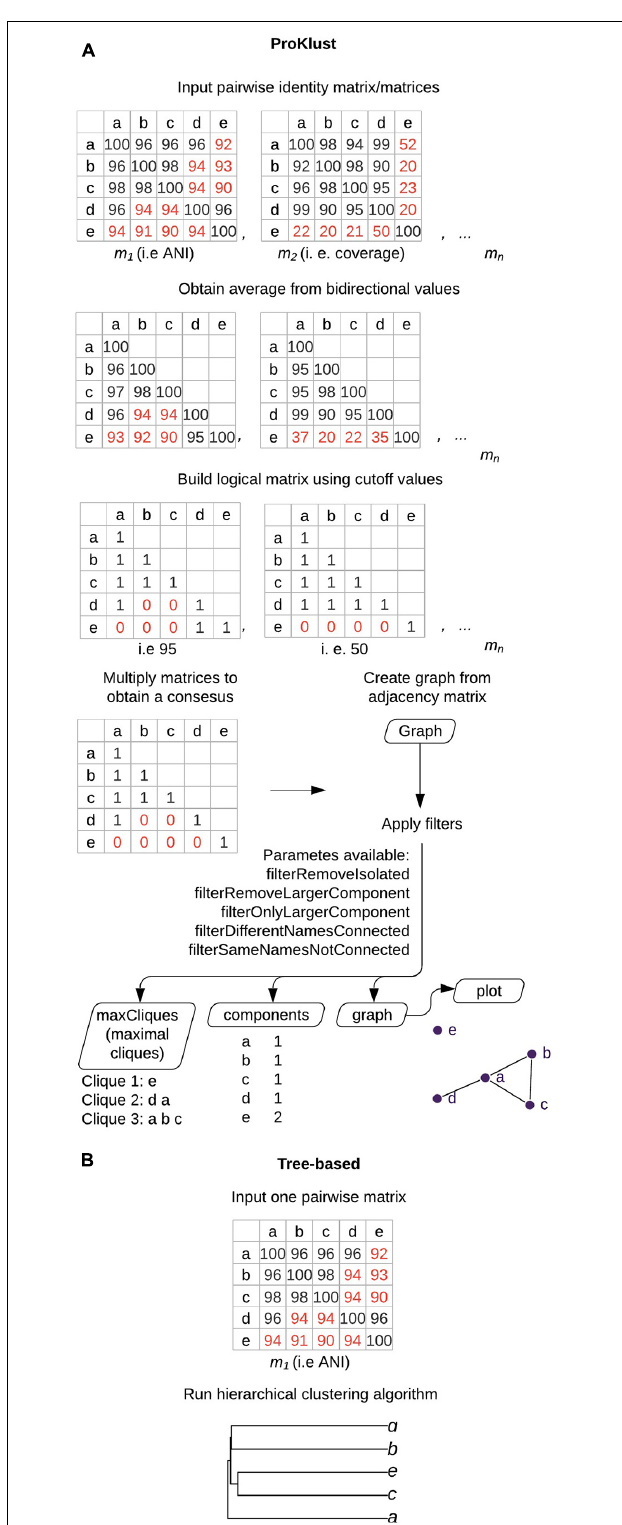
FIGURE 2 | Graph-based clustering using ProKlust compared to hierarchical clustering. (A) The average of each pair from the pairwise